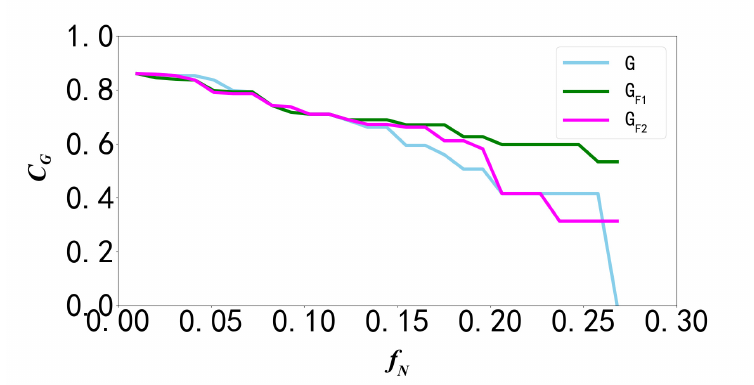
Figure 9. Comparison of defense results of different defense methods under the same attack strategy. The blue line indicates the result of HDA direct attack on the original network G , the green line indicates the result of HDA attack on the original network G F 1 defended by the AHDNG, and the magenta line indicates the result of HDA attack on theoriginal network G F 2 defended by the random disguised